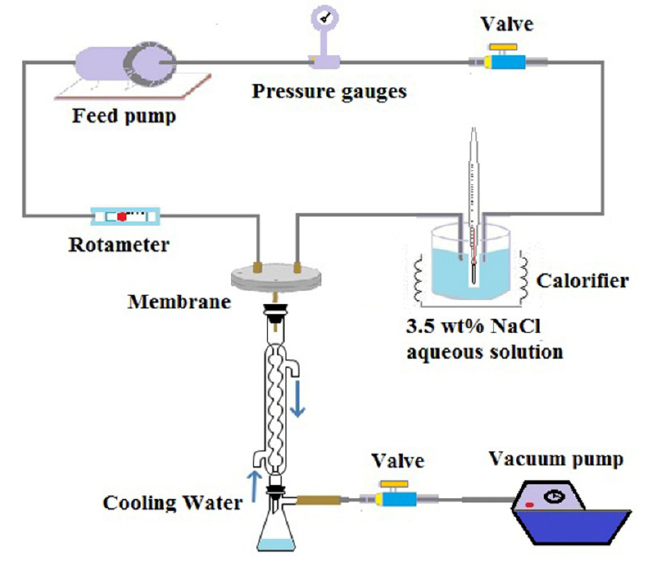
Figure 4. Schematic diagram of the experimental VMD apparatus.